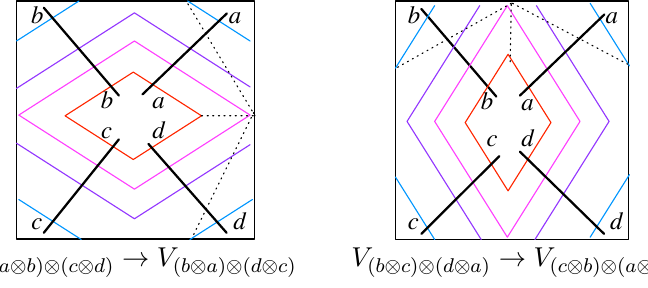
Figure 49 . The product is invariant under exchanging an incoming circle and an outgoing circle.